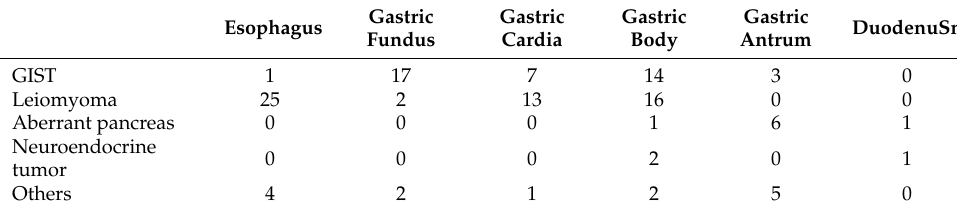
Table 2. Association of histopathology pattern and tumor